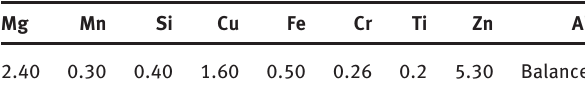
Table 1: The chemical composition of A7075 aluminum alloy (wt.%).